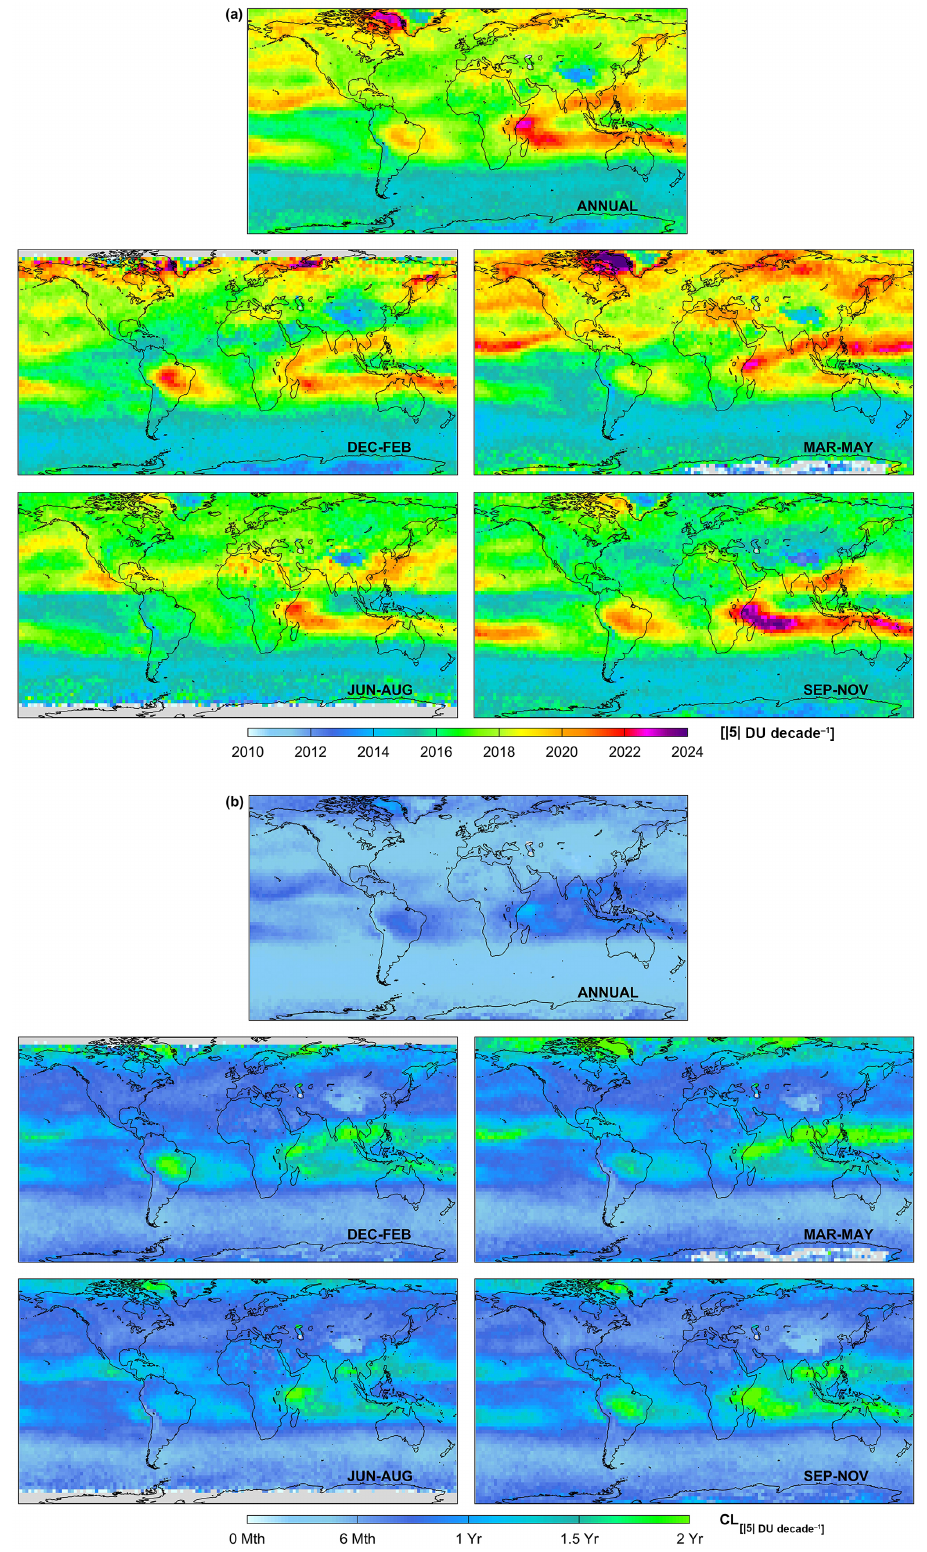
Figure 6. (a) Estimated year of tropospheric IASI O 3 trend detection (with a probability of 90%) for a given trend of | 5 | DUdecade − 1 starting at the beginning of the studied period (20080101) and (b) associated maximal confidence limits from the annual (top panel) and the seasonal (bottom panels) regression